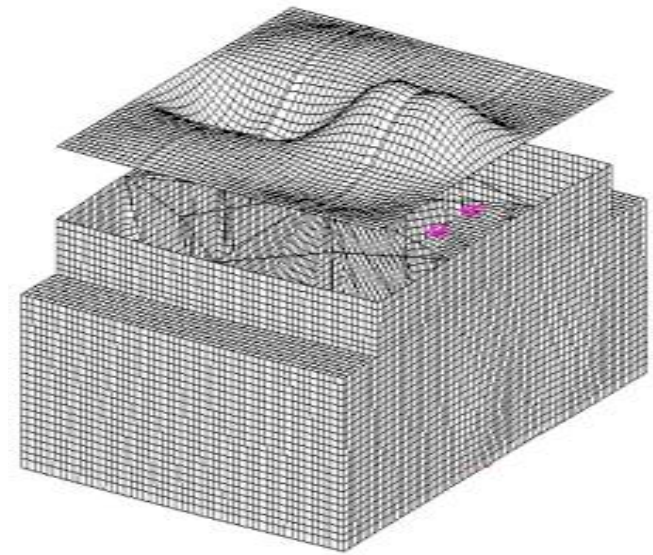
Figure 13. The local modal shape of the optimal design (59.677